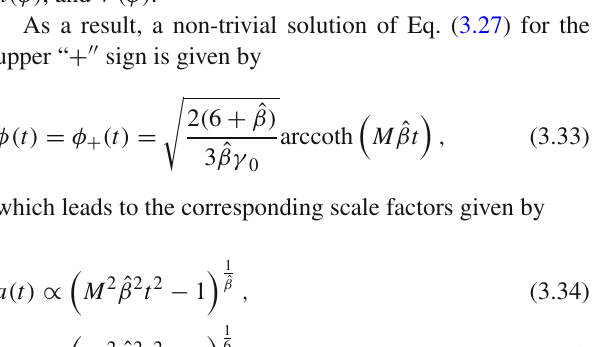
Fig. 2 Behavior of h (φ) (left) and V (φ) (right) associated with φ − ( t ) for ˆ β = 0 . 1 and γ = 1 . 5. 0 Here, h 0 is an integration constant. This plot shows that h (φ) is always larger than one. In addition, it also shows that V (φ) is negative definite when φ approaches zero (the negativity region of V (φ) is displayed as the dotted